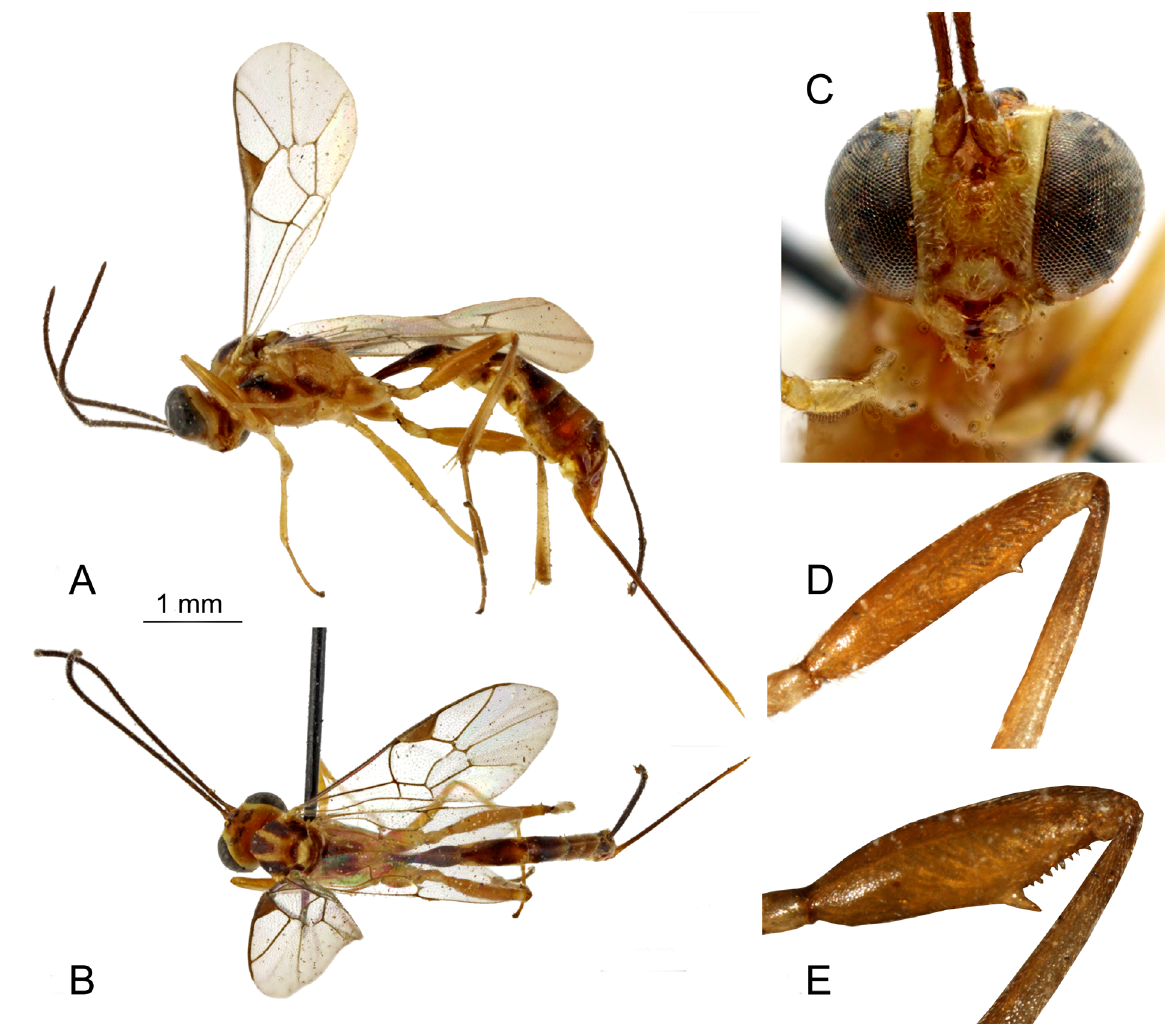
Fig. 3. Pristomerus albescens (Morley). A . ♀, habitus, profile. B . ♀, habitus, dorsal. C . ♀, head, facial. D . ♀, hind femur, profile. E . ♂, hind femur,